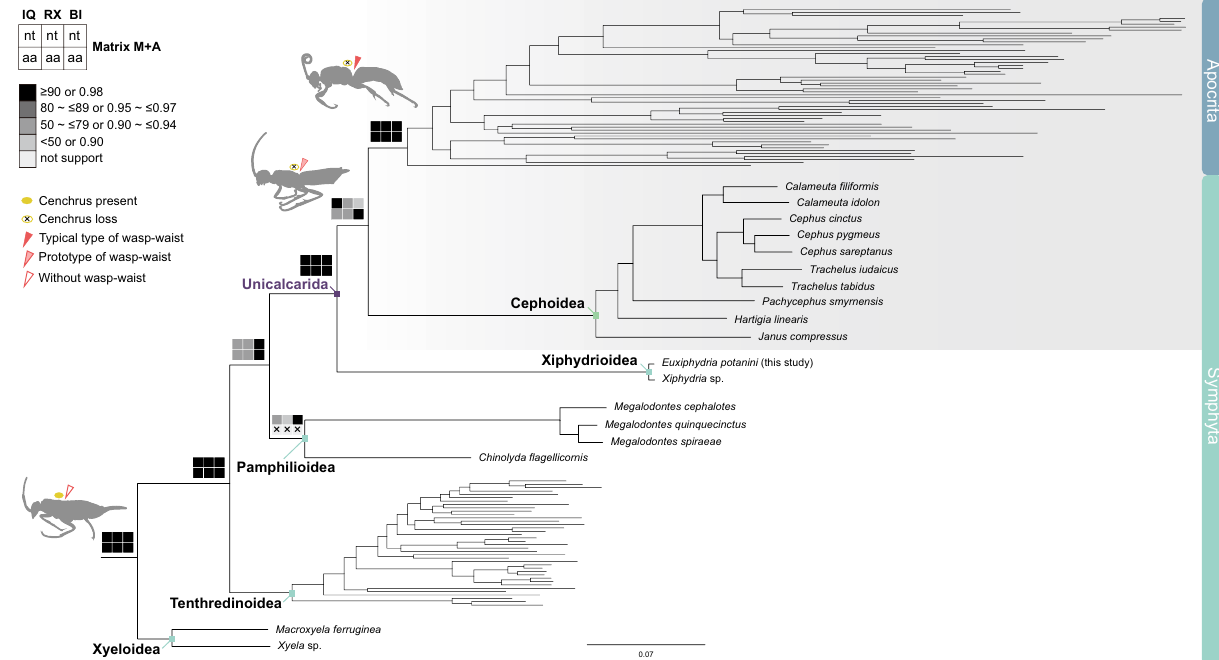
Figure 5. ML tree showing phylogenetic relationships of hymenopteran superfamilies without Orussoidea and Siricoidea based on the mitochondrial nucleotide sequence alignment set (Mnt + A) with the depiction of morphological character transitions of the cenchrus and wasp-waist during the hymenopteran evolution. The tree was constructed using IQ-TREE web server 37 and it is shown as a representative for six phylogenetic trees including IQ-TREE (IQ)-based ML, RAxML (RX)-based ML, and MrBayes-based BI trees from Matrices Mnt + A and Maa + A (Figs. S44–49). Node confidence values resulting from the six trees are plotted on the respective branches of the ML tree by black, dark gray, gray, and light gray boxes along with ranges of bootstrapping values or posterior probability as specified in the upper left